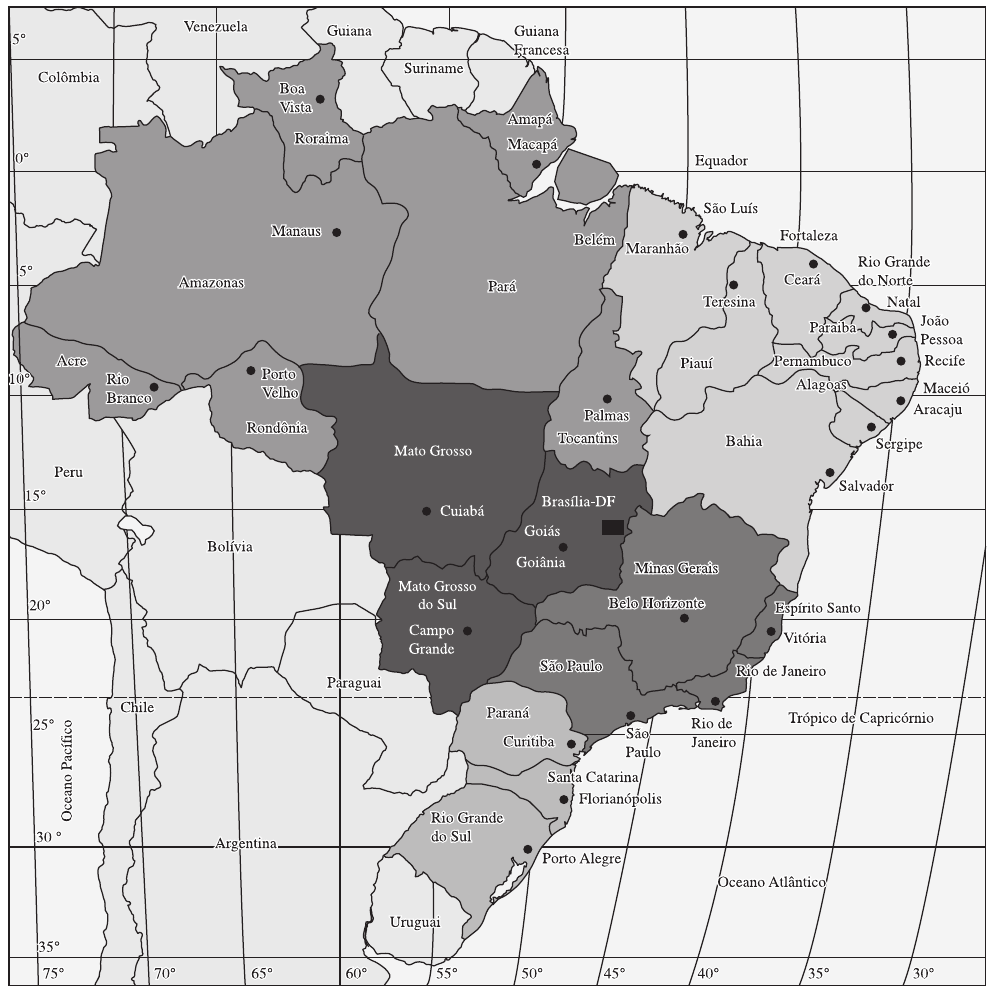
Figure 4. Localization of São Paulo State.